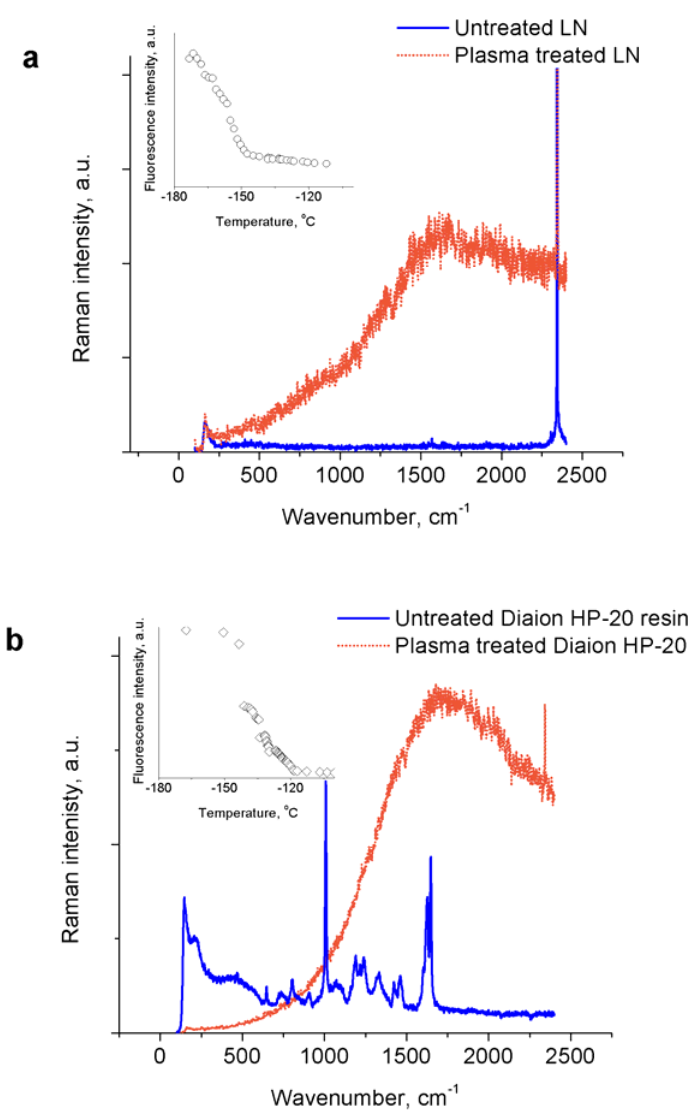
Figure 2. Raman spectra of untreated liquid nitrogen (LN) ( a ) and Diaion HP-20 resin ( b ) and treated with nanosecond-pulsed spark plasma. Inserts show decrease of the overall fluorescence intensity with increase of the sample temperature after evaporation of liquid nitrogen (linear scales). Peak around 2330 cm − 1 originates from molecular nitrogen.